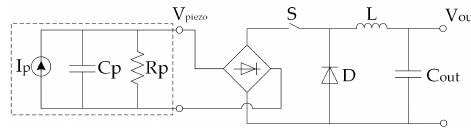
Figure 46. The S-SSHI ( a ) and the P-SSHI ( b ) rectifiers.